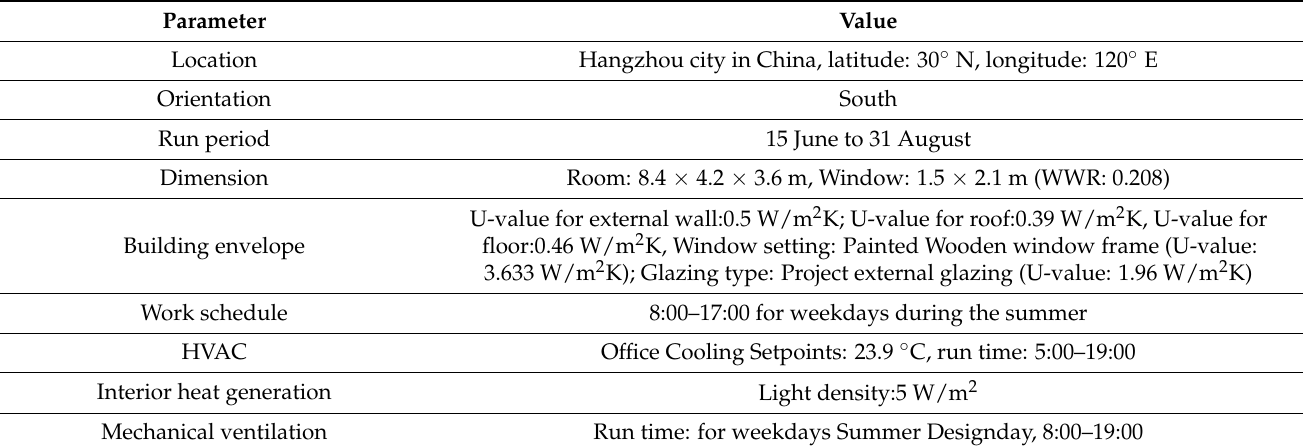
Table 2. Characteristics of simulation